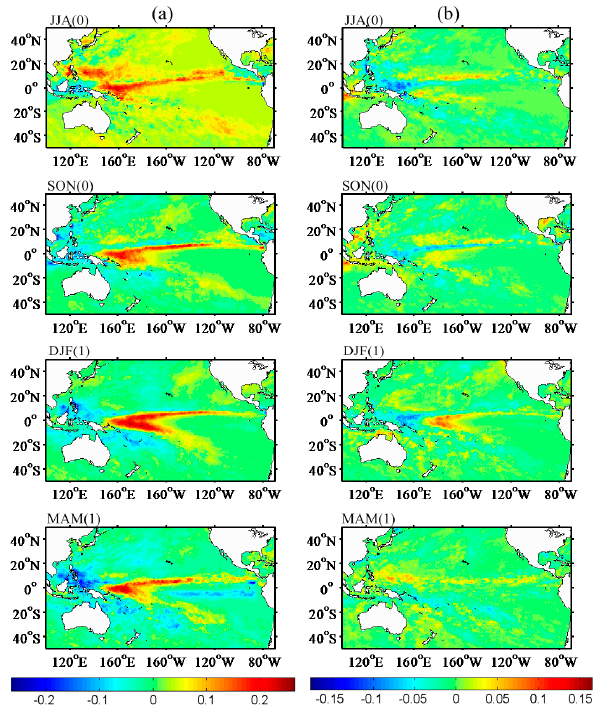
Figure 4. ( a ) Spatial patterns of the first SEOF mode (SEOF1) of seasonal precipitation anomalies from June–July–August of year 0 (JJA(0)) to March–April–May of the following year (MAM(1)); ( b ) as in ( a ), but for the second mode (SEOF2). Units: mm/hr.